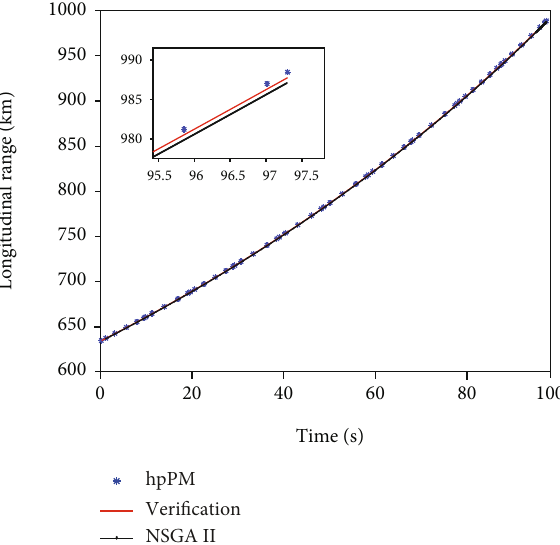
Figure 20: Longitudinal